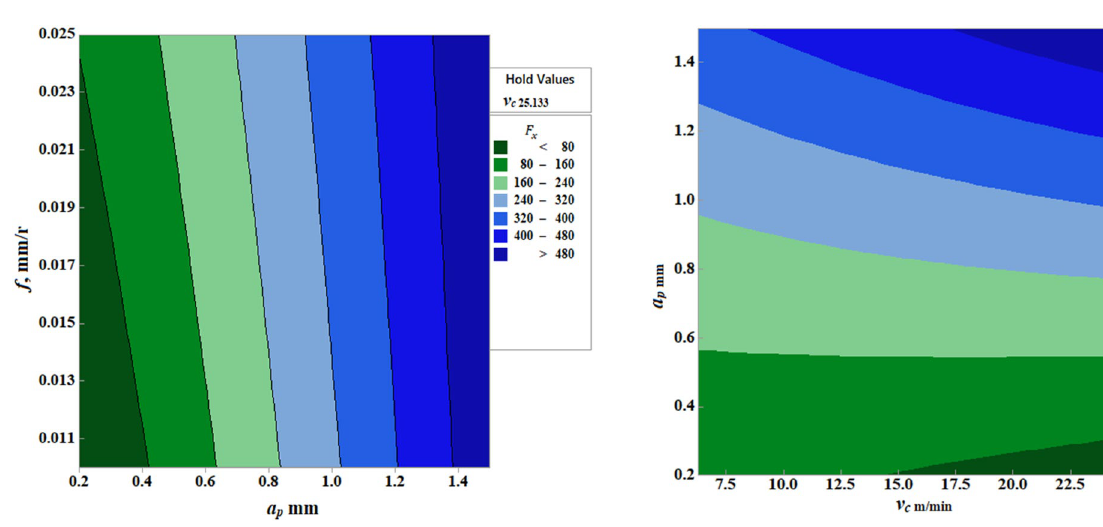
Fig. 4 Cutting force F x vs f , and a